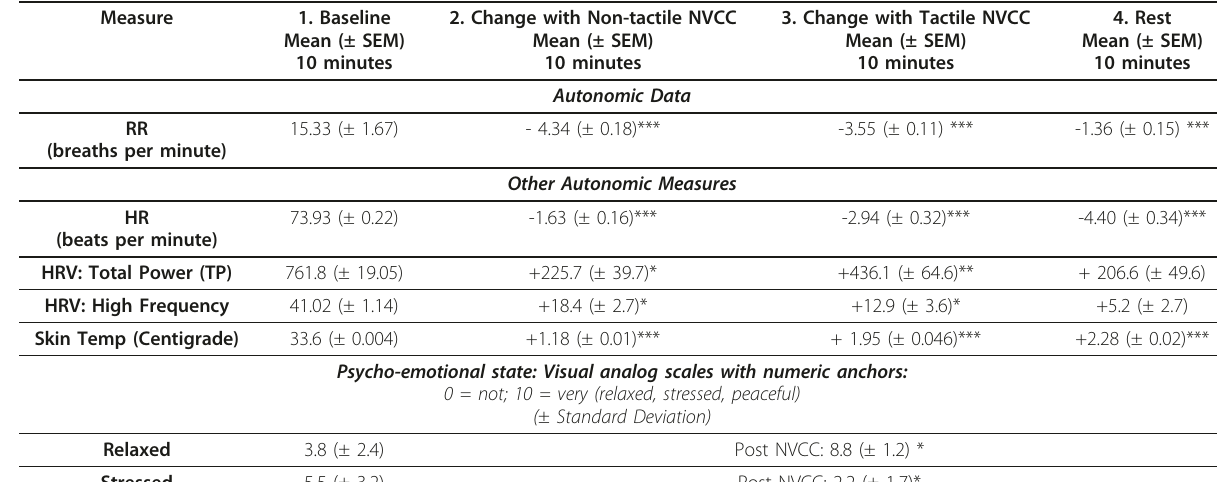
Table 1 Changes from Baseline in Average Autonomic Nervous System Activity and Psycho-emotional State for Non- tactile NVCC, Tactile NVCC, and Follow-up Rest in 6 healthy subjects Measure